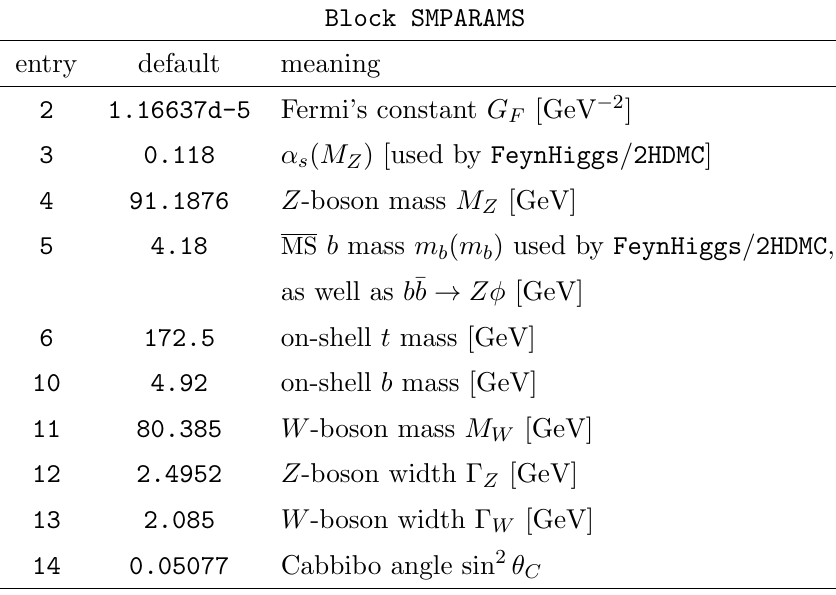
Table 7 . Setting the SM input